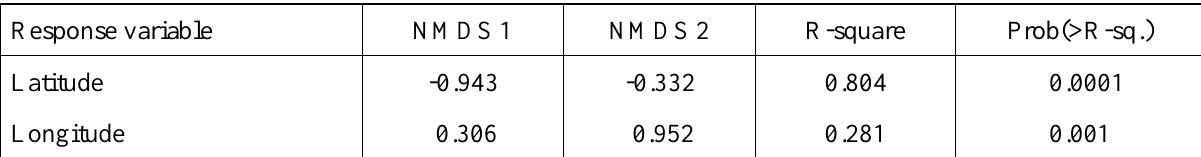
Figure 2. Non-metric multidimensional scaling of the 47 pine, bog woodland communities under study based on raw compositional dissimilarities. Convex hulls were used to group the communities by region (country). Table 2. Independent linear fit of the geographical coordinates (latitude and longitude) of all relevés against their scores along the two axes extracted through non-metric multidimensional scaling